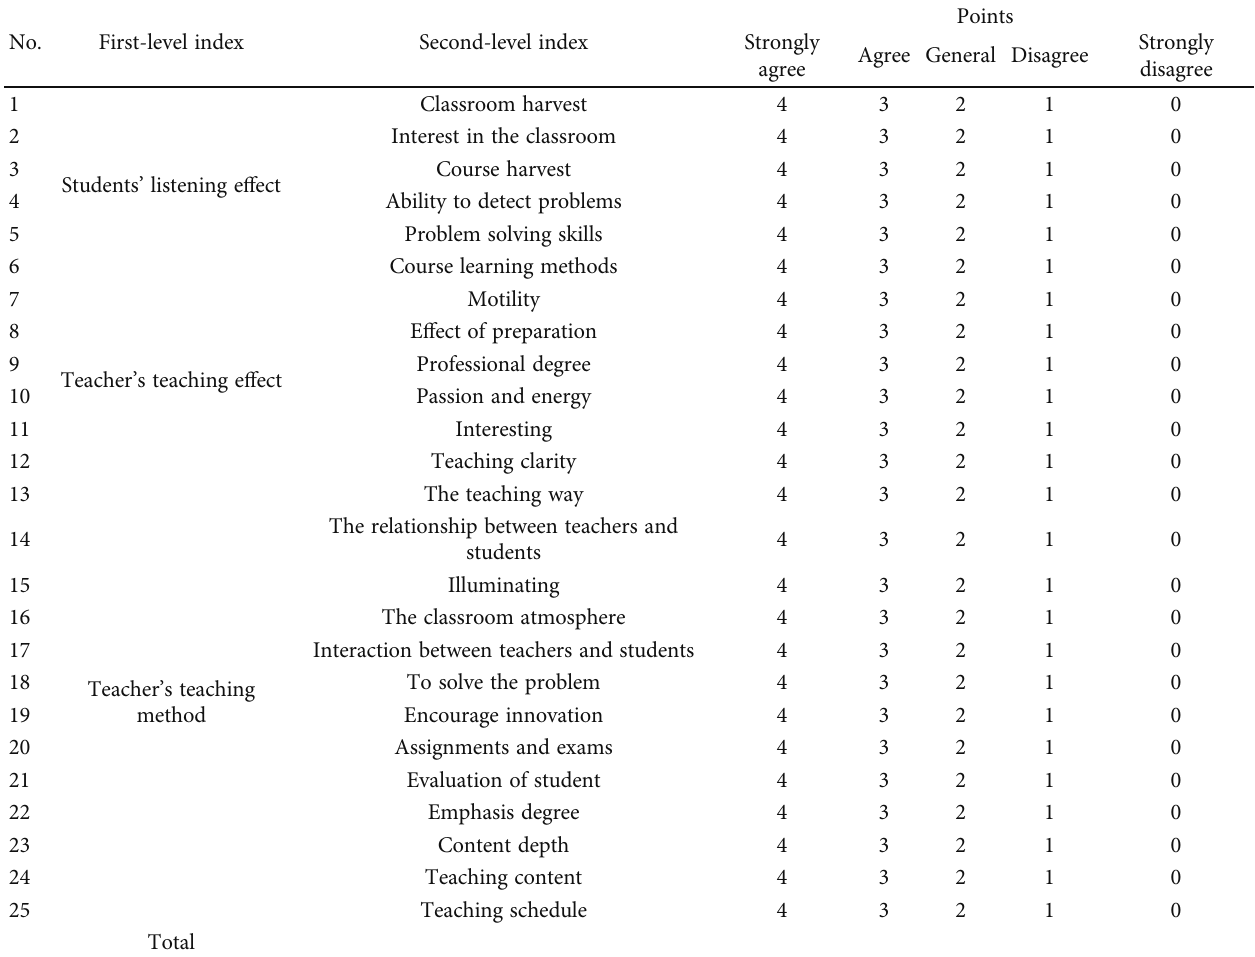
Table 8: Questionnaire of students ’ evaluation of